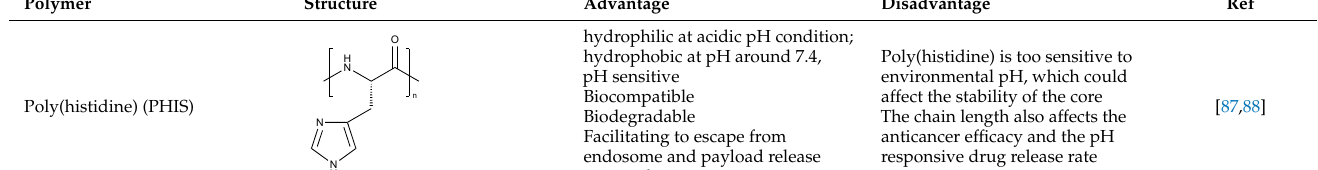
Table 2. Features of hydrophobic polymers commonly used for polymeric micelles.